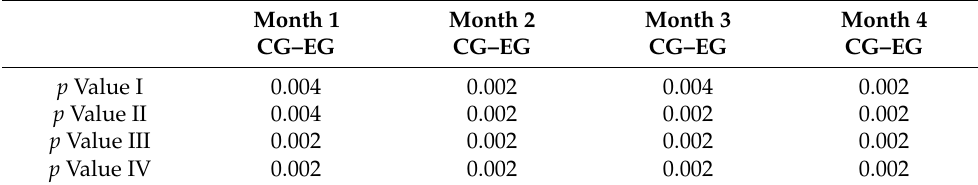
Table 3. Non-parametric test of the sign comparing quadrants.